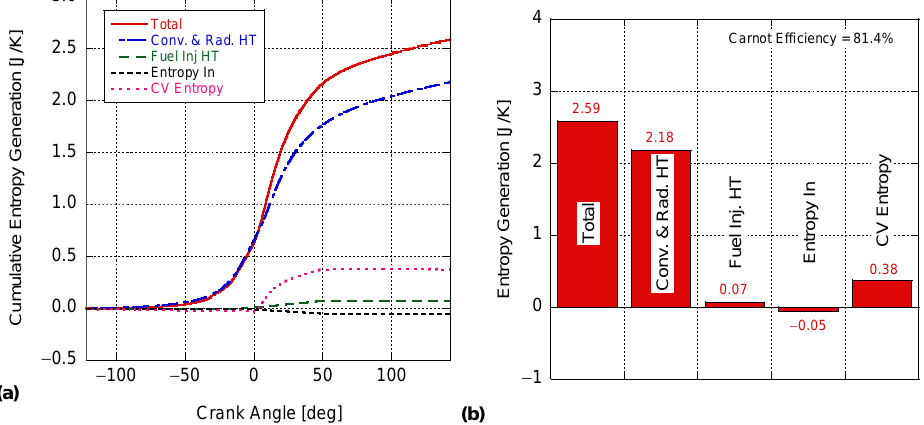
Figure 11. ( a ) Cumulative entropy generation as a function of crank angle and ( b ) the results of the different components in the conservation of entropy equation.